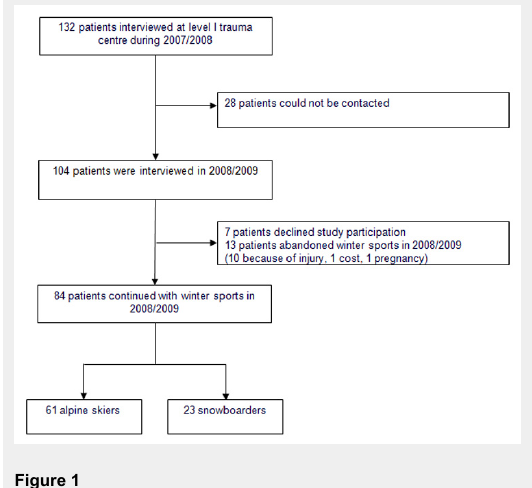
Flow chart of study patients.